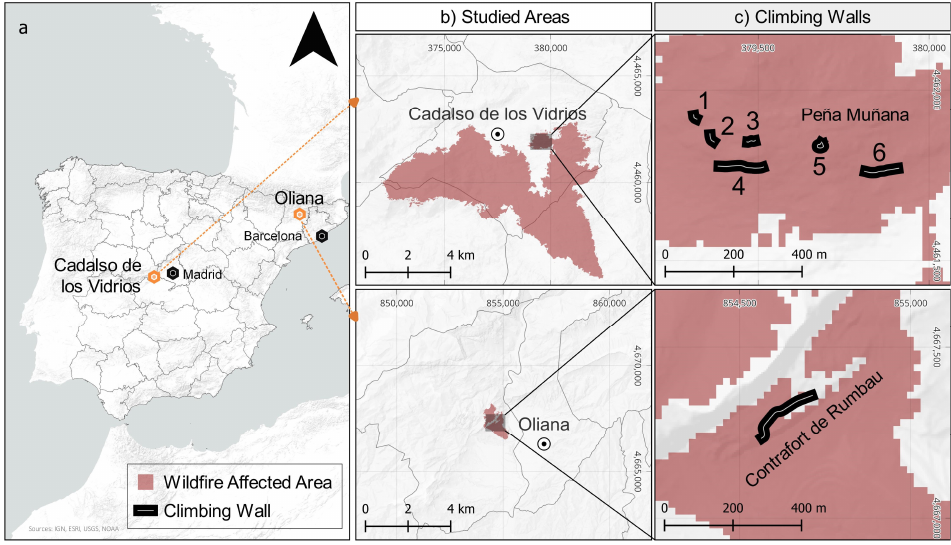
Figure 3. Location of the studied areas: ( a ) general situation map; ( b ) studied areas—Oliana ( top ) and Cadalso de los Vidrios ( bottom ); ( c ) climbing walls (bold black line). The numbers in the Cadalso area indicate six different climbing